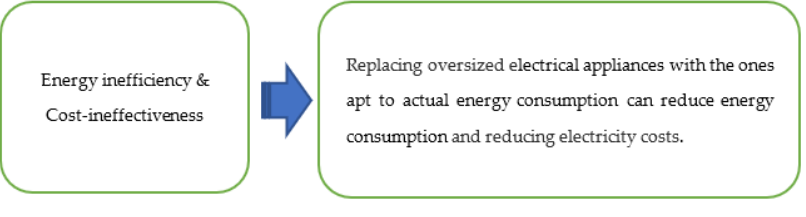
Figure 2. Management constraints and the assumption of the study.